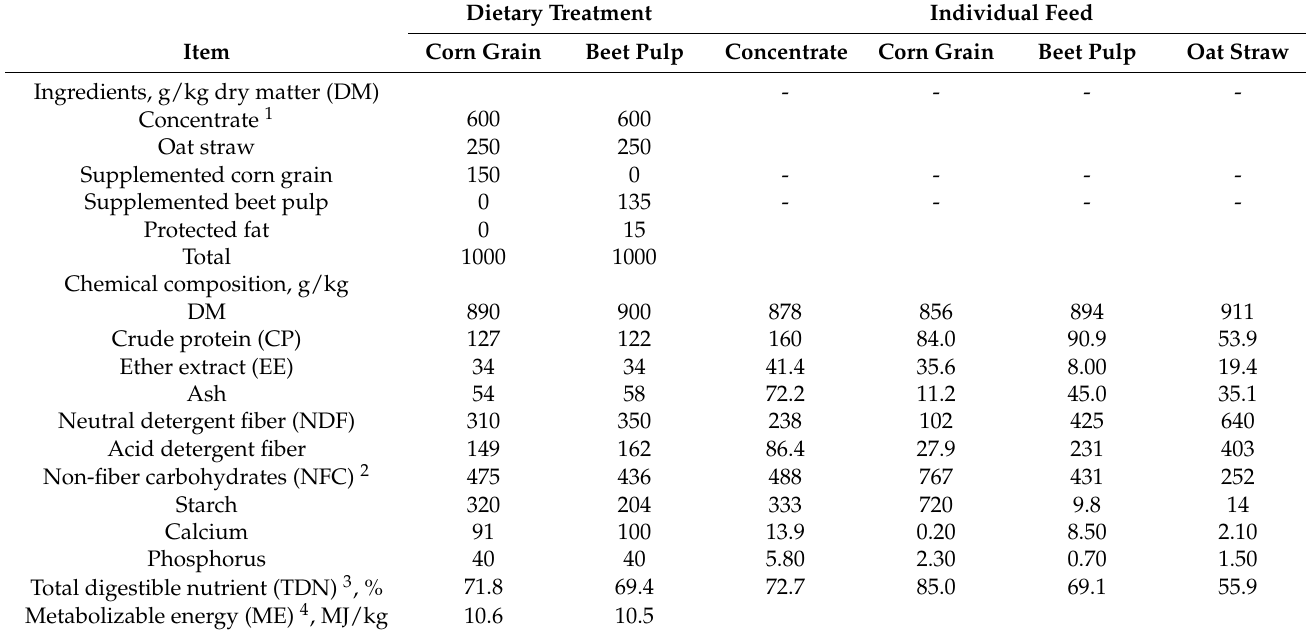
Table 1. Ingredient and chemical compositions of diets and individual feeds. Dietary